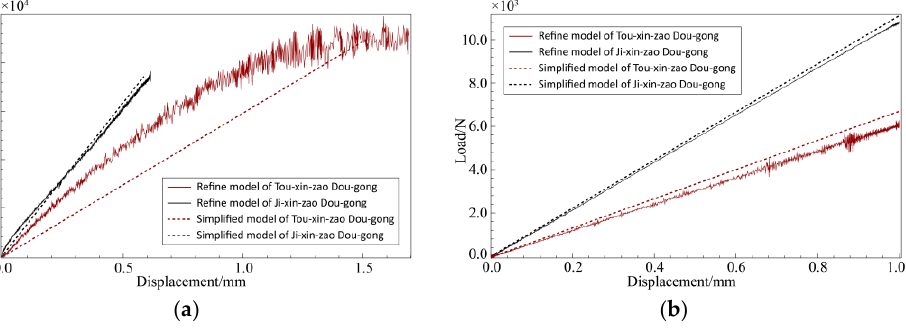
Figure 18. Comparison of the load – displacement curves, refined model vs. simplified model: ( a ) roof load condition; ( b ) collapse condition.